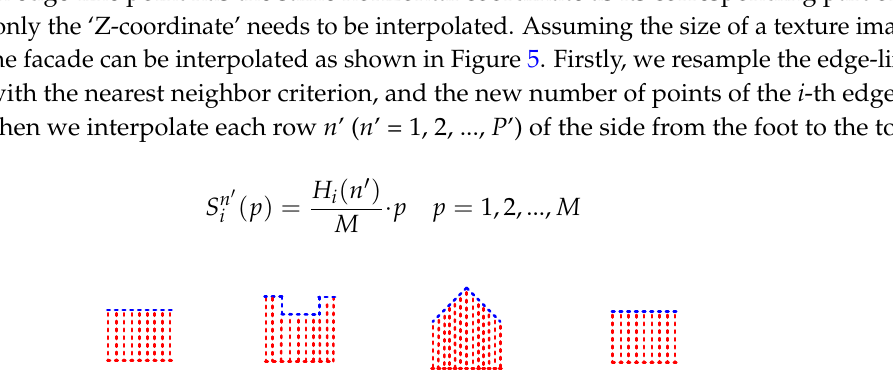
Figure 5. Generated building facades with interpolated points.